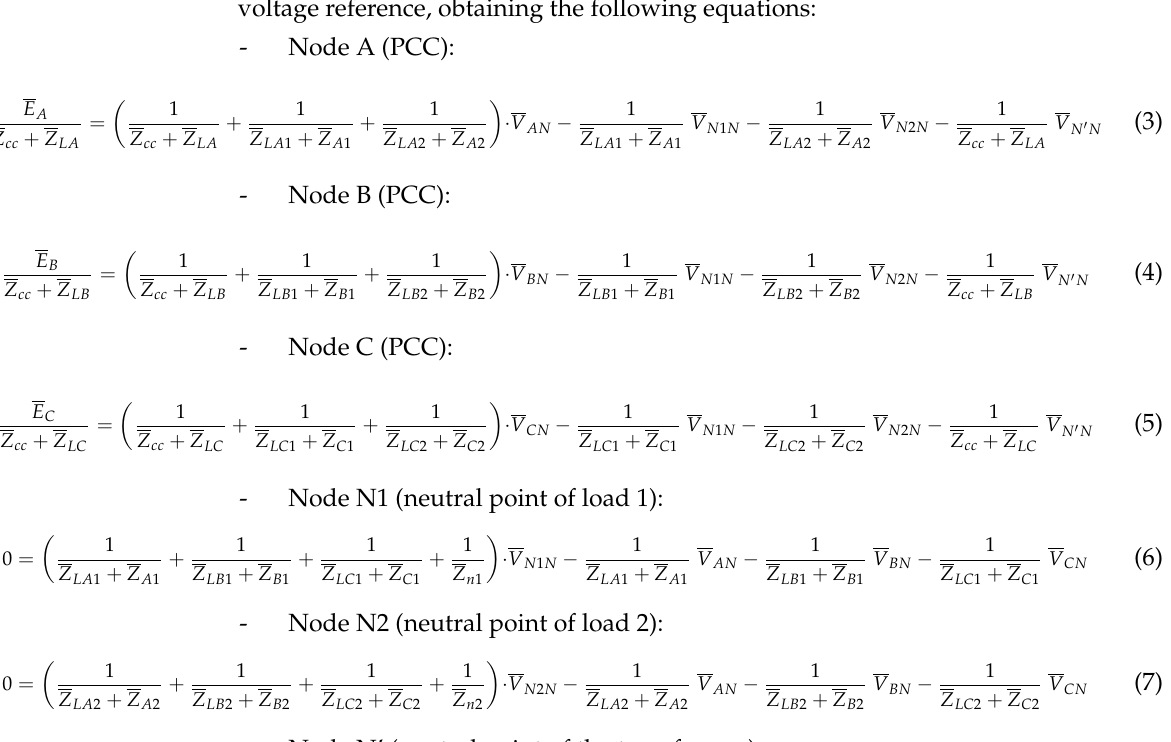
where S N is the rated power of the transformer, ε % is the rated short-circuit voltage (in %), and P JN is the rated copper losses. (b) Analysis of the system in stage (15) of the programming module. This stage includes the calculation of the phase voltages and currents of the different subsystems. To do this, the analysis method of node voltages is applied to the system represented in Figure 1, using the node N, corresponding to the neutral point of the PCC, as the voltage reference, obtaining the following equations: